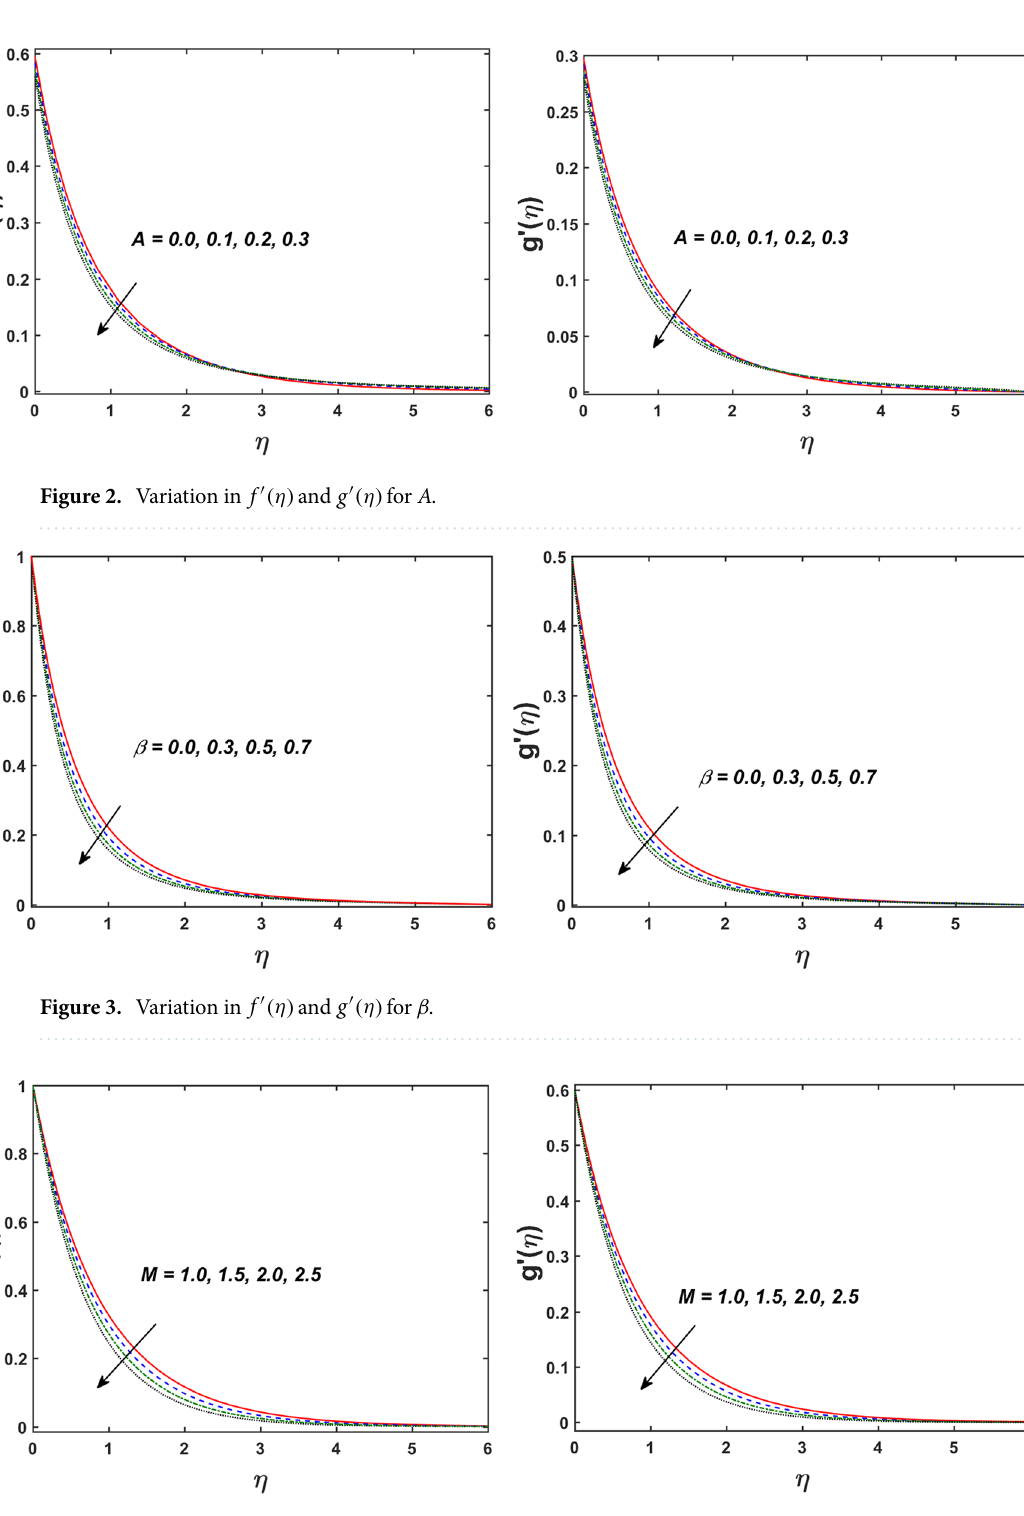
Figure 4. Variation in f ′ (η) and g ′ (η) for M